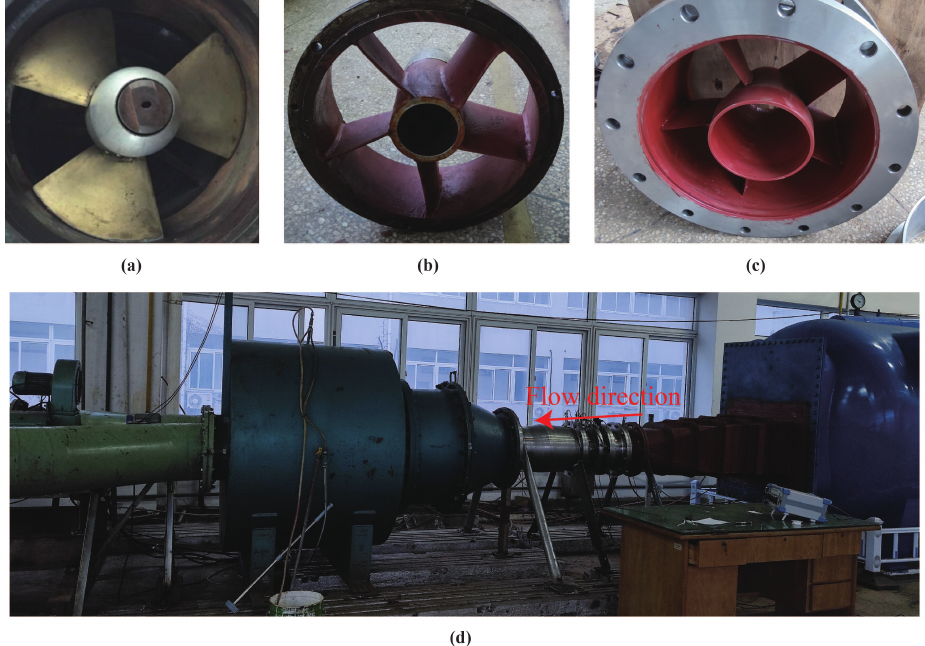
Figure 4. Submersible tubular pump device: ( a ) GL-2008-03 impeller; ( b ) conventional guide vane; ( c ) diffuser guide vane; ( d ) bulb rear-mounted submersible tubular pump